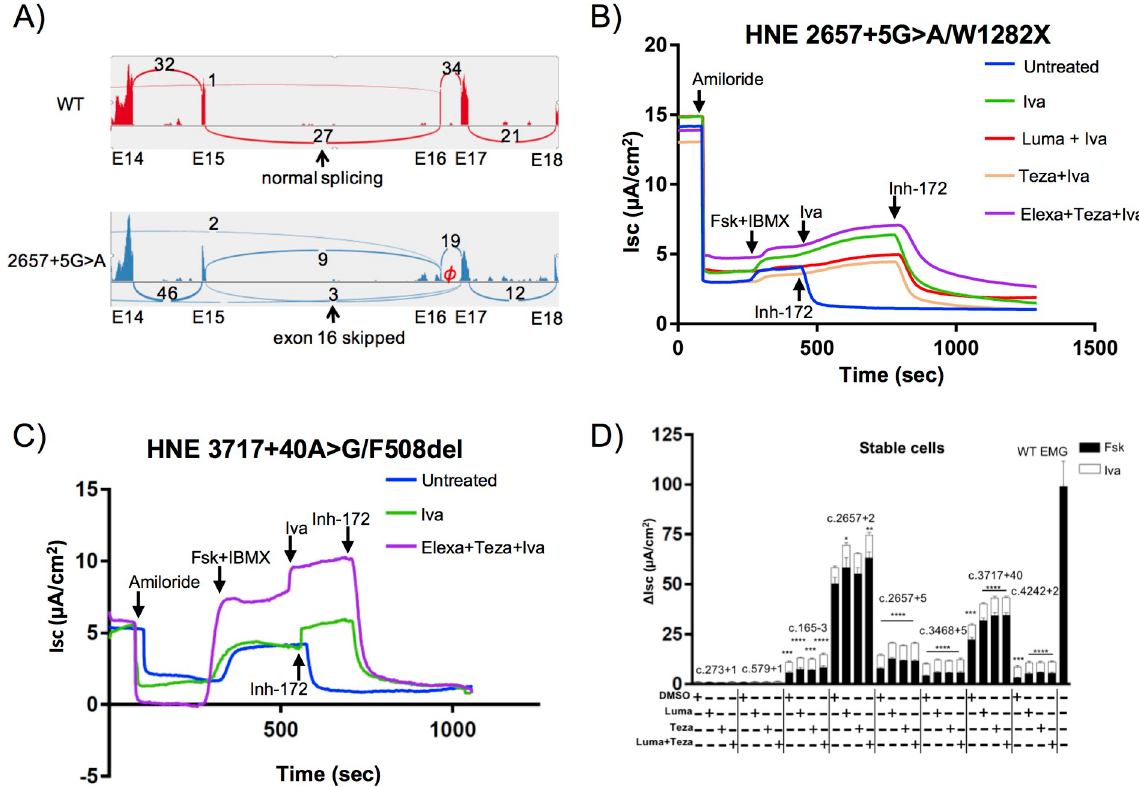
Fig 4. CFTR intronic splice site variants with residual function are responsive to CFTR modulators. (A) Sashimi plots showing skipping of exon 16 caused by 2657+5G > A variant . RNA-seq was performed on the total RNA extracted from nasal cells of the individual harboring c.2657+5G > A/W1282X genotype. RNA from healthy individual served as a control. Per-base expression is plotted on y-axis of Sashimi plot. ‘E’ refers to exon locations on x-axis. +5 on the Sashimi plot indicates variant is located in intron 16 (not to scale). Numbers on the Sashimi plot indicate counts of reads spanning exon junctions. f on the illustration indicates relative location of the variant c.2657+5 G > A. (B) Residual full-length CFTR transcript allows for modulator response in a c.2657+5G > A/W1282X individual . Representative short circuit current (I sc ) tracings on Human nasal epithelial (HNE) cells harvested from an individual harboring c.2657+5G > A/W1282X. CFTR channel function and CFTR modulator response were evaluated in well-differentiated airway liquid interface (ALI) culture. (C) Primary cells from an individual harboring c.3717+40A > G/F508del respond to modulator therapy. Representative short circuit current (I sc ) tracings on Human nasal epithelial (HNE) cells harvested from an individual harboring c.3717+40A > G/F508del. CFTR channel function and CFTR modulator response were evaluated in well- differentiated airway liquid interface (ALI) culture. (D) Intronic variants that allow for residual normal splicing respond to modulator therapies. Stacked bar graphs indicate effect of modulator treatment on CFBE stable cells expressing different CFTR intronic variants. Change in current ( Δ I sc ) was defined as the current inhibited by Inh-172 after sustained I sc responses were achieved upon stimulation with forskolin alone or sequentially with ivacaftor. Data shown as mean ± SEM (minimum of three independent measurements per condition). p value was determined by one-way ANOVA. ���� ( p � 0.0001), n.s. (not significant, p > 0.05) when compared to DMSO treated vehicle control. Data underlying graphs in this figure reported in S5 Data